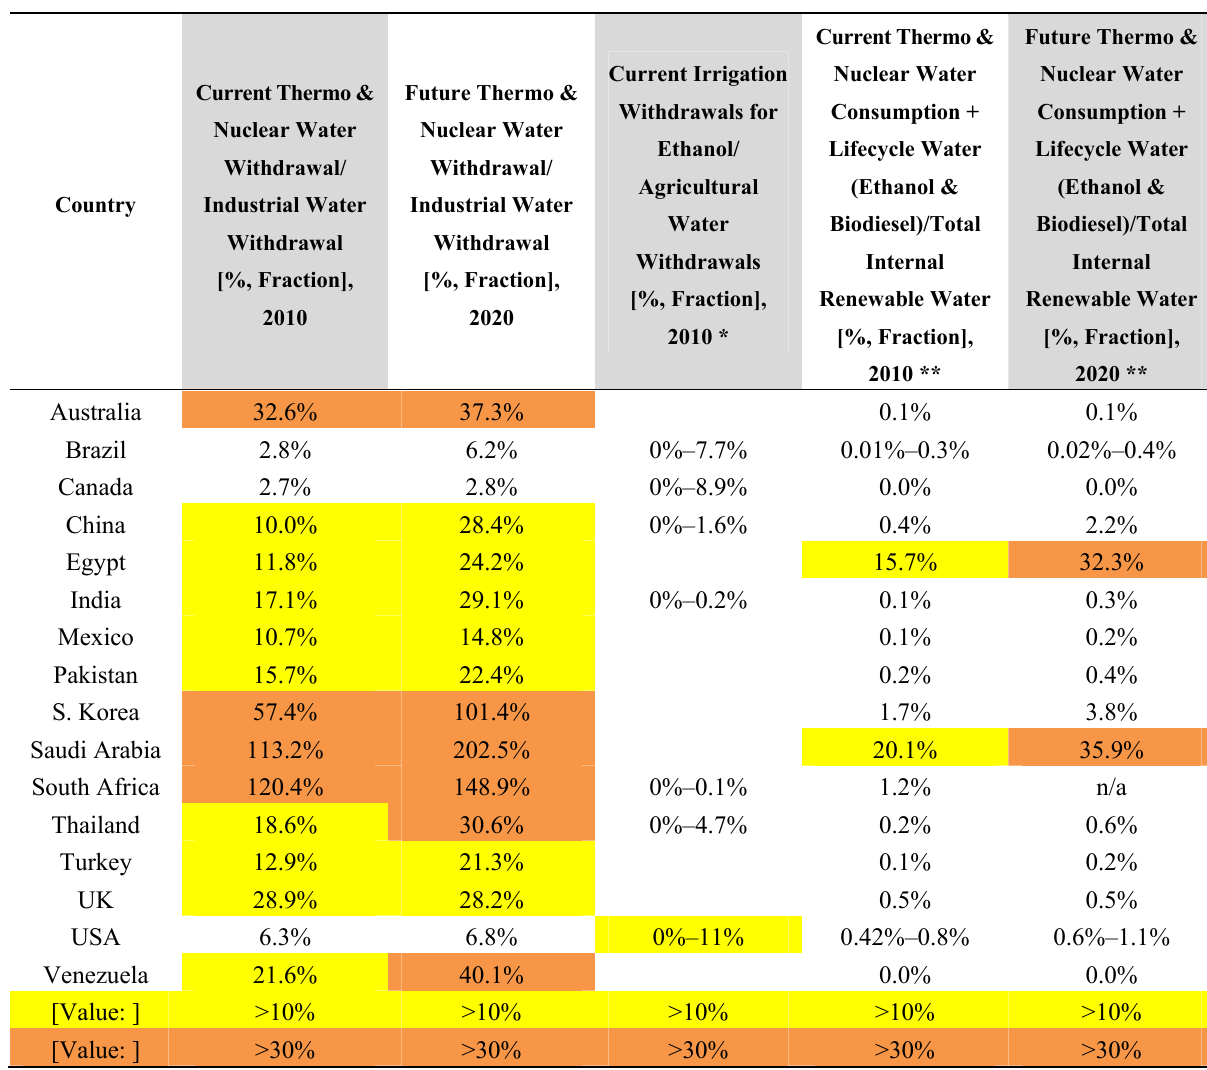
Table 1. Water withdrawals for thermoelectric and nuclear power generation as fractions of industrial water withdrawals; and total water withdrawals for energy (thermoelectric and nuclear power generation, and biofuels feedstock irrigation), 2010 and 2020. Water withdrawals are defined as diversions from freshwater bodies (FAO AQUASTAT) [26], not depletion through evaporation. Color coding shown at bottom of